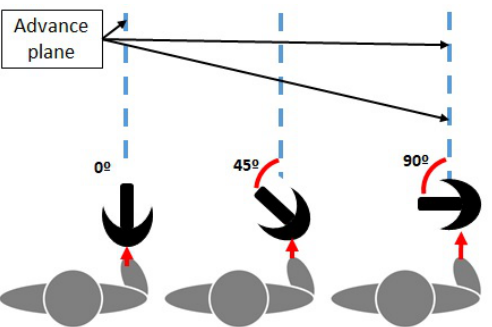
Figure 4. Position of the crutch handle with respect to the advance plane, in the different validation tests of Euler angles provided by the X-Sens.